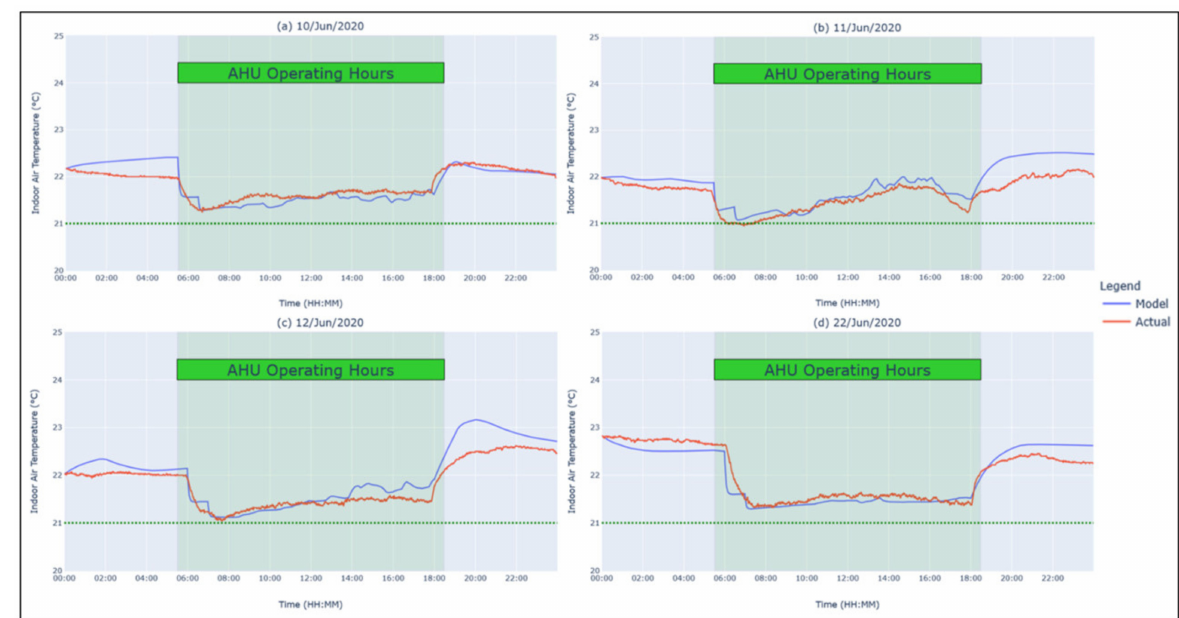
Figure 5. Illustration of model vs. empirical internal air temperatures for selected validation days: ( a ) 10/Jun/2020; ( b ) 11/Jun/2020; ( c ) 12/Jun/2020; ( d ) 22/Jun/2020, with AHU operating hours highlighted by green shaded